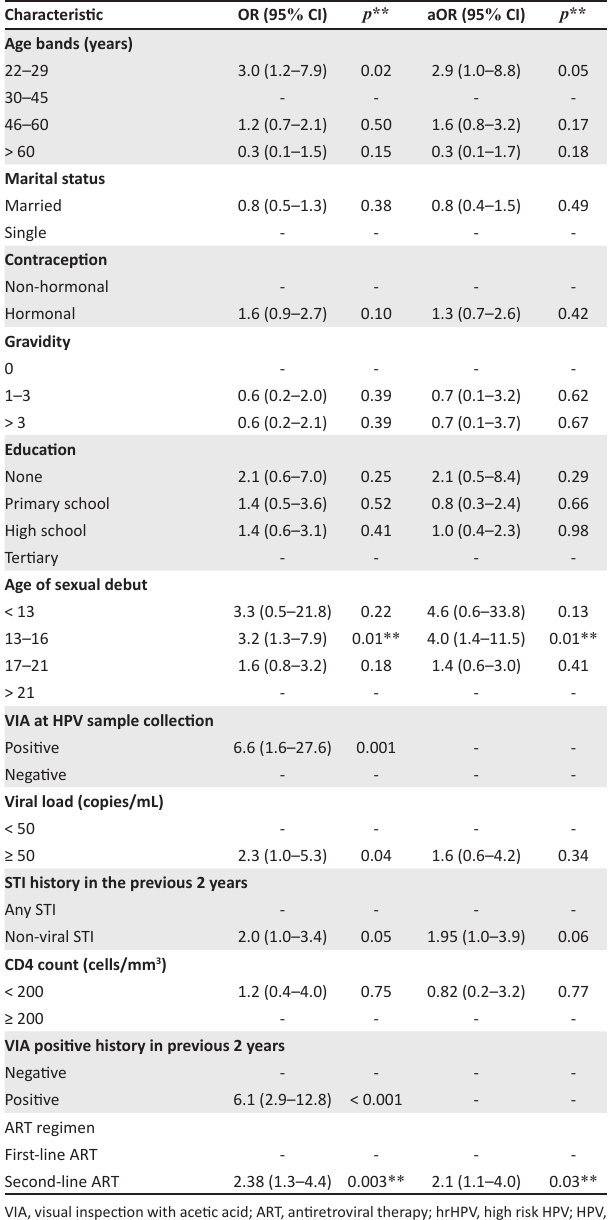
TABLE 2: Univariate and multivariate analysis of patient characteristics associated with high-risk human papillomavirus positivity.